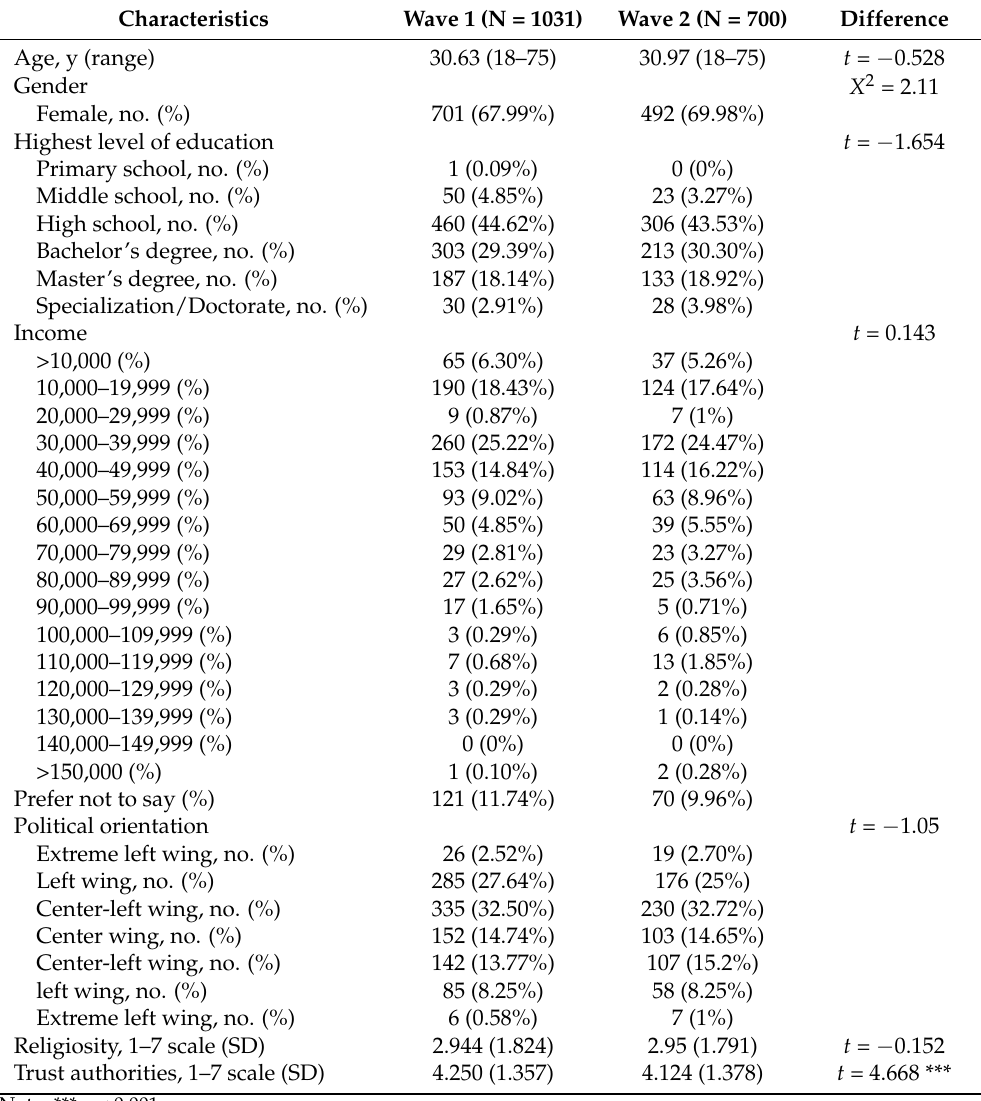
Table 1. Characteristics of the participants and responses to the main survey items in the two waves of the